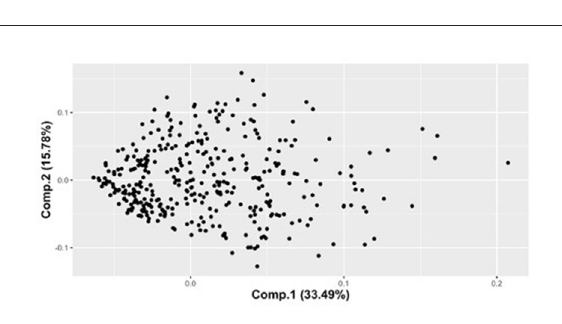
FIGURE5 Score plot of cats on the first (PC 1) and second (PC 2) principal components, with the increase in